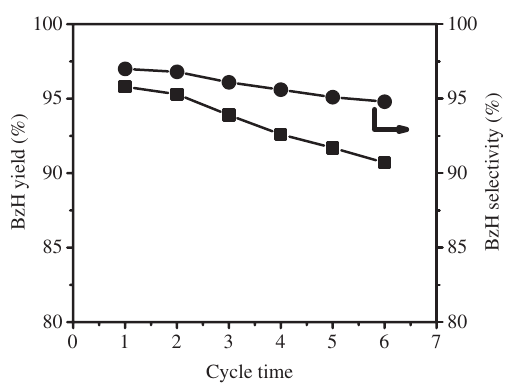
PW O catalyst on BzH yield 2 12 40